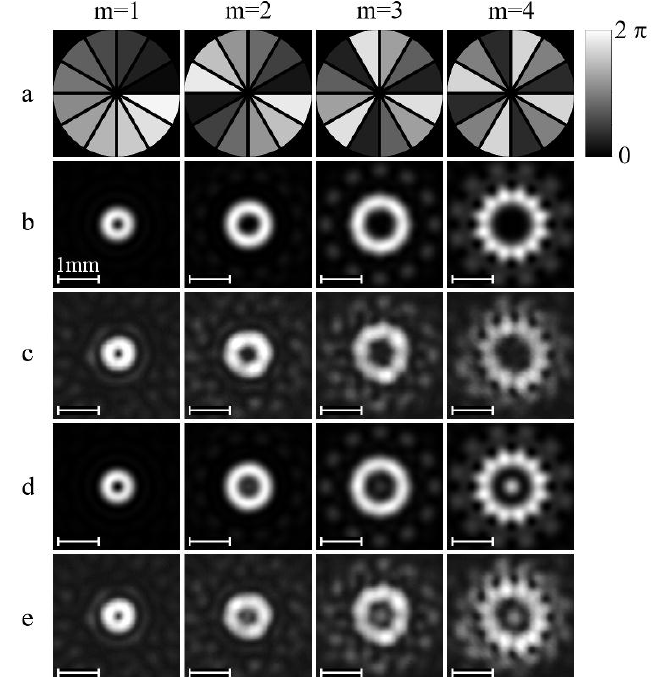
Fig. 1. The formation of axially symmetric vortex fields with a topological charge m from 1 to 4 by using a 12-sector spiral phase plate based on a FLC-587-F7: (a) specified phase distributions on the spiral phase plate in gray gradations; calculated (b) and experimentally measured (c) intensity distributions in the far field in the presence of a polarizer; calculated (d) and experimentally measured (e) intensity distributions in the far field without a